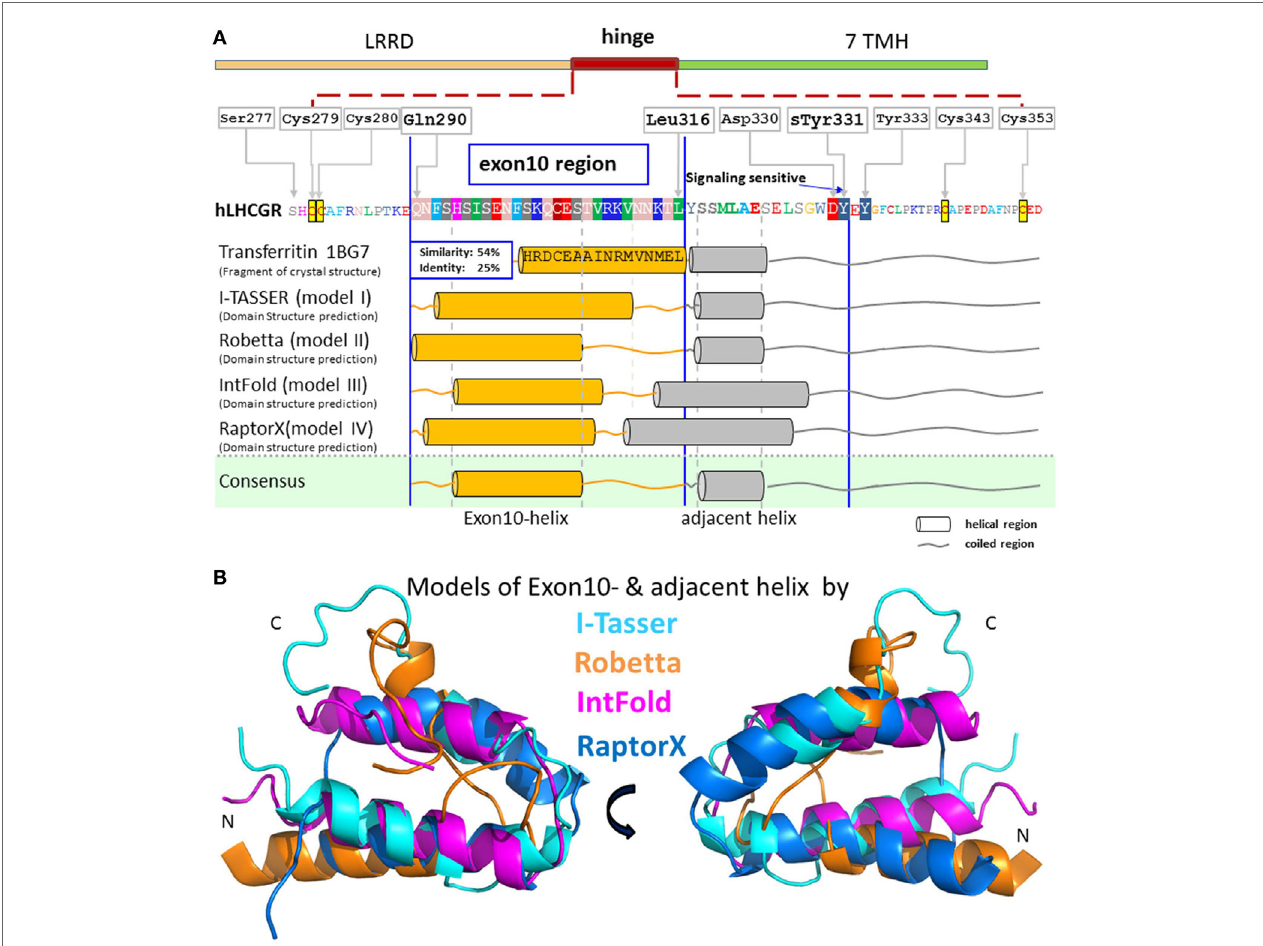
FigUre 2 | Predicted structural segments for the middle part of the extracellular hinge region of lhcgr . For exon10, and the following residues, there is great sequence similarity to the crystal structural fragment of transferritin, which contains a helix. Four different methods I-TASSER [Cyan in (B) ] (30, 31), Robetta [orange in (B) ] (32), IntFold [magenta in (B) ] (33), and RaptorX [blue in (B) ] (34) predicted a common tertiary structure of the middle hinge region resulting in two helix segments, one for the exon10-region [orange cylinders in (a) ] and for the following residues [gray cylinders in (a) ]. Due to the consistent helix predictions by different methods and with the existing helix structure in homologous fragments, it is likely that this sequence contains a high propensity for an exon10-helix and an adjacent helix. The hormone binding sensitive sulfation site sTyr331 is located in an accessible coiled